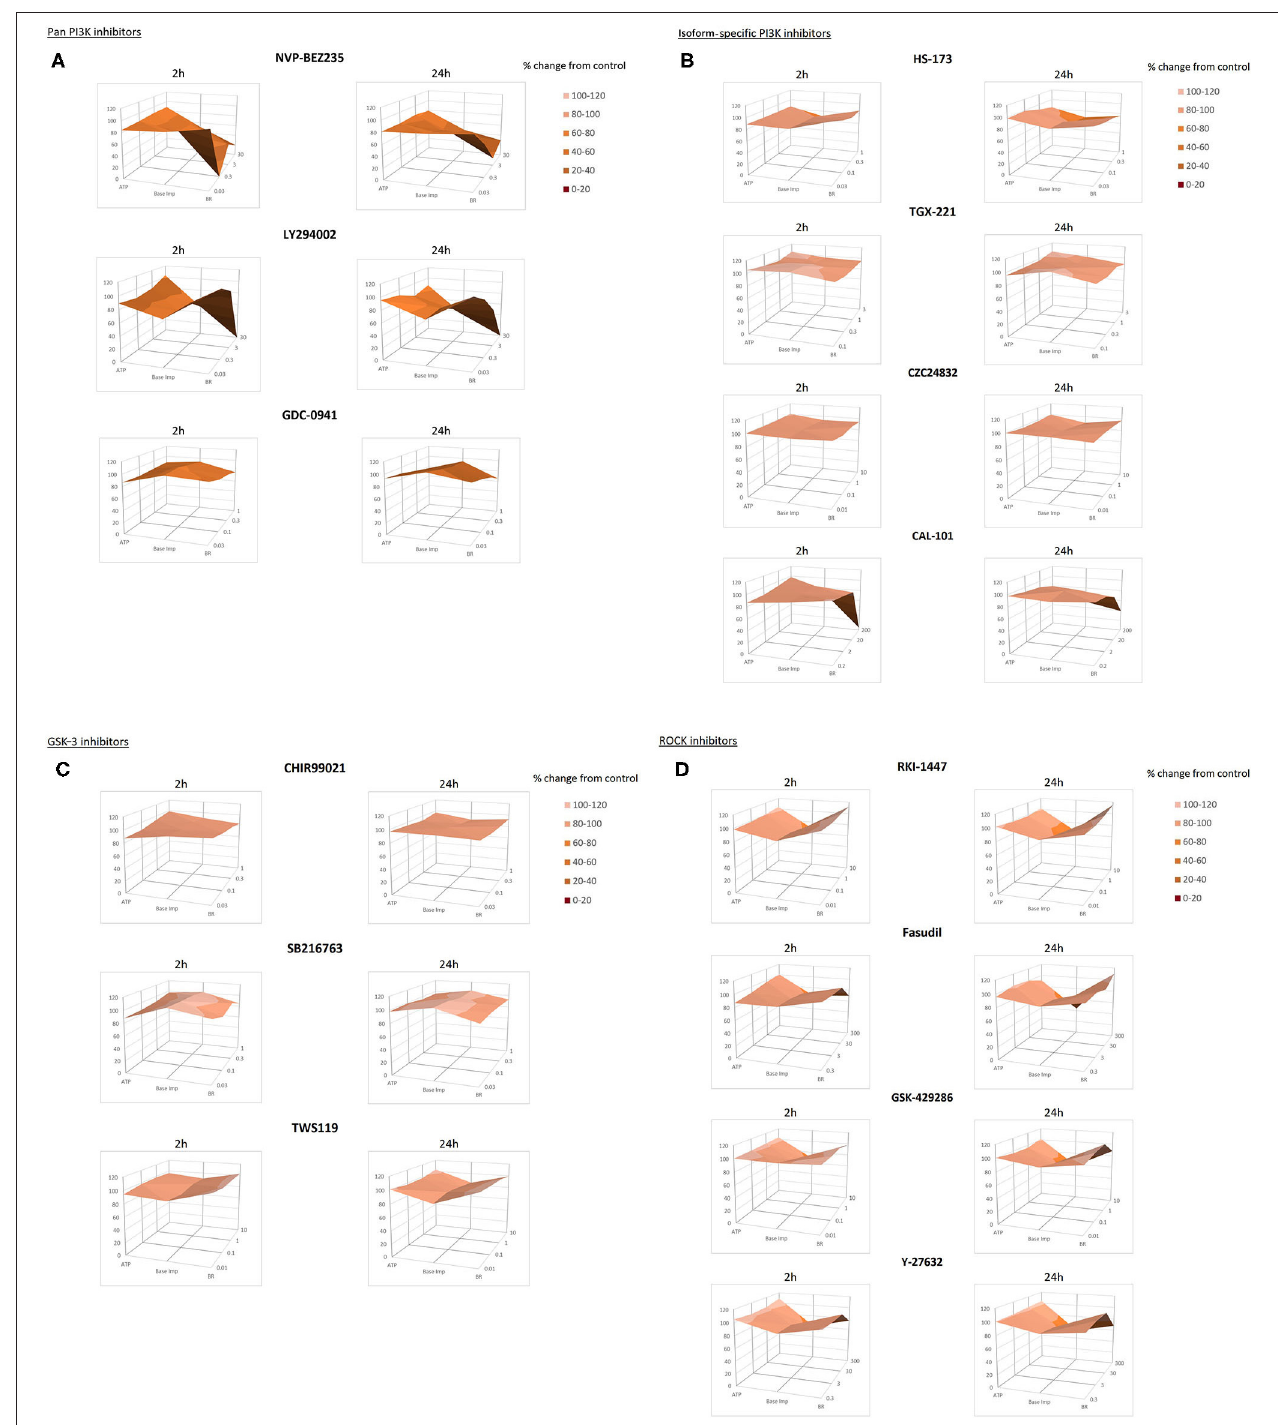
FIGURE 3 | Surface plots for beating rate, base impedance and ATP measured in hSC-CMs after 2 and 24h of incubation with kinase inhibitors. (A–D) show the results for the PI3K-pan, PI3K isoform-specific, GSK-3 and ROCK kinase inhibitors, respectively. Surface plots intend to show compound-specific relationships between individual functional parameters in hSC-CMs: beating rate, base impedance and ATP content. The plots are constructed using the average of 3–5 repeats for each parameter. Similar colors indicate the areas that are in the same range of values specified in the legend.